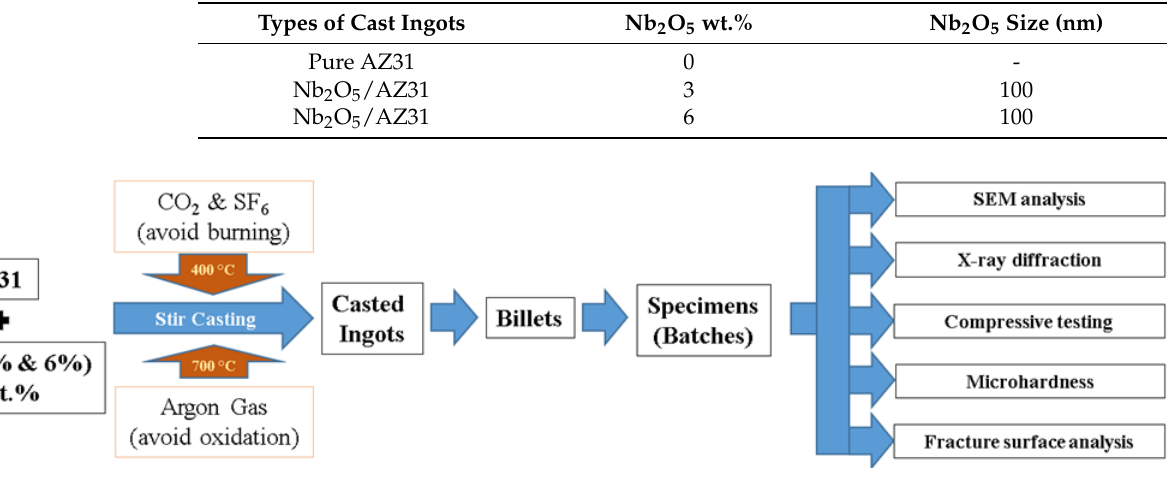
Figure 1. Schematic of Experimental Methodology.